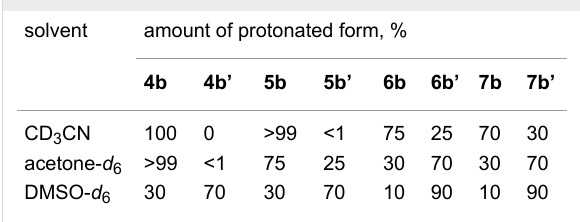
Table 1: Influence of the solvent on the proton transfer to imino nitrogen in 4b – 7b solutions at 25